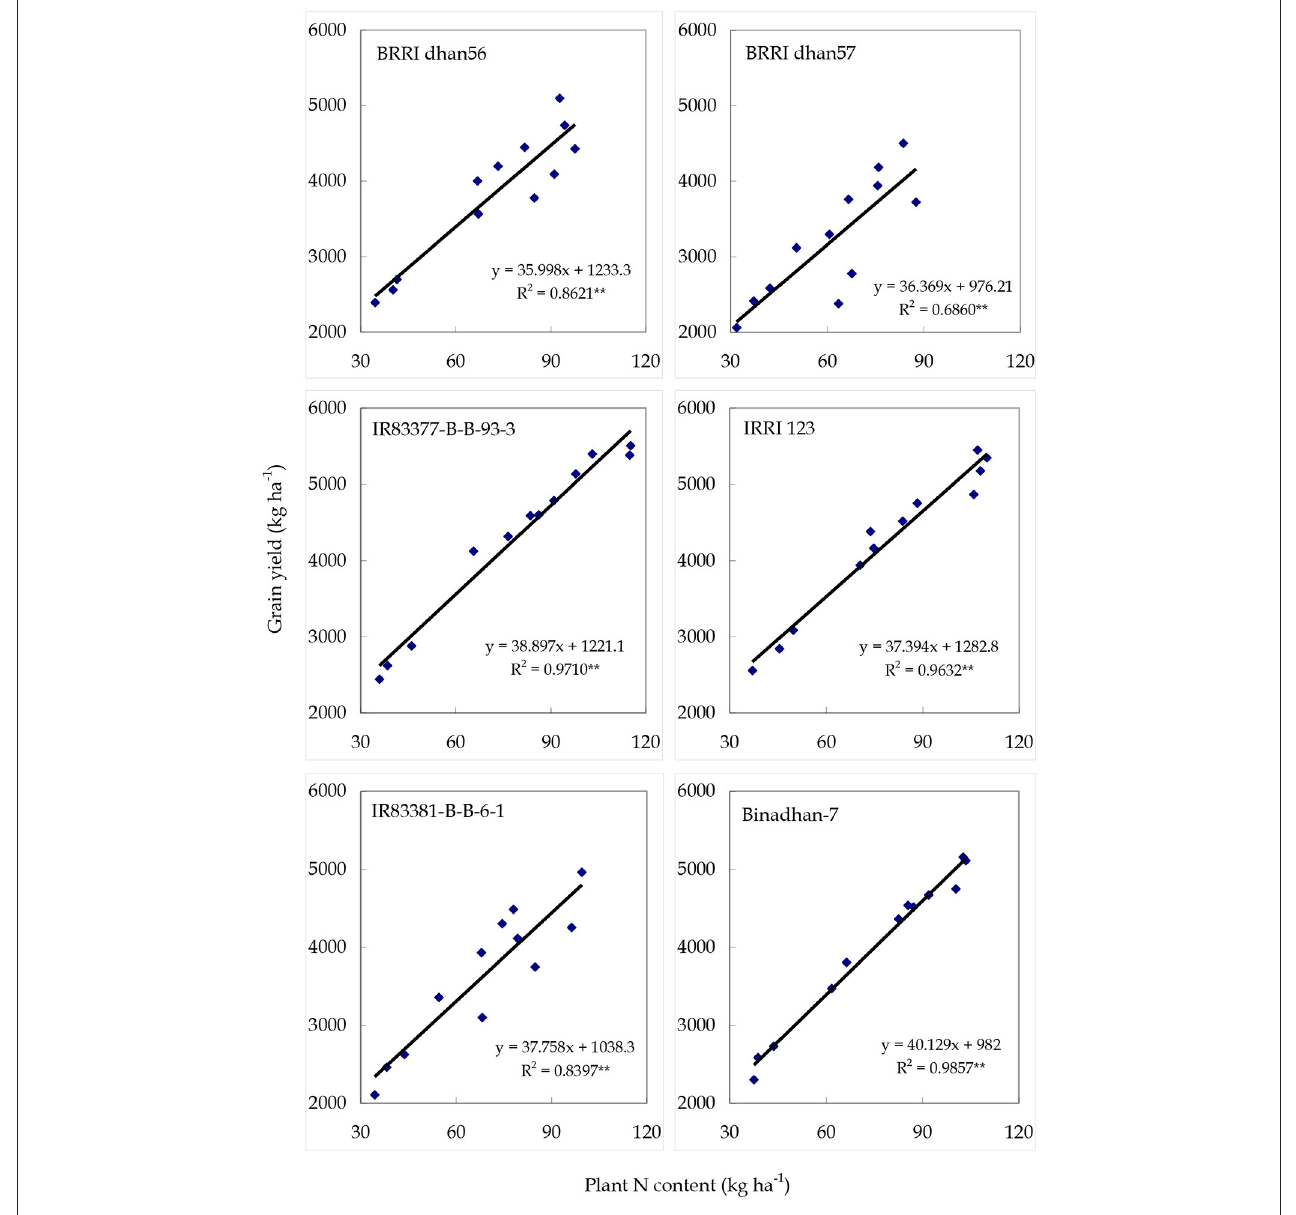
FIGURE 6 | Relationship between grain yield and plant N contents at maturity of the tested rice genotypes (averaged over N